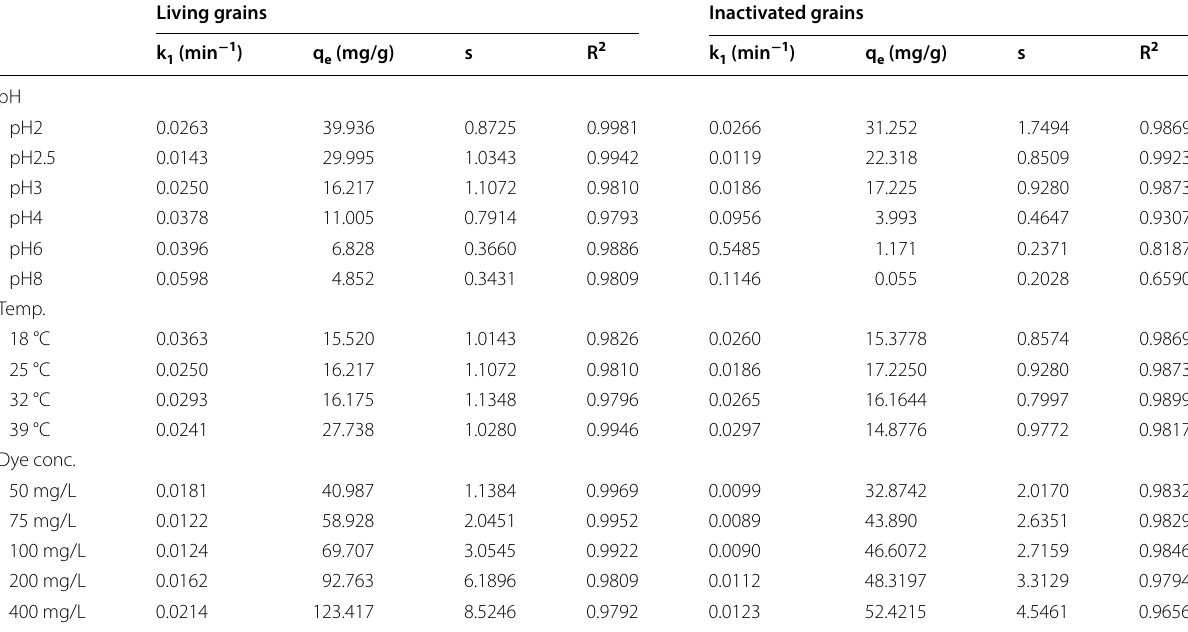
Table 2 Pseudo-first-order kinetic model parameters for removal of Remazol Navy by kefir grains at different process